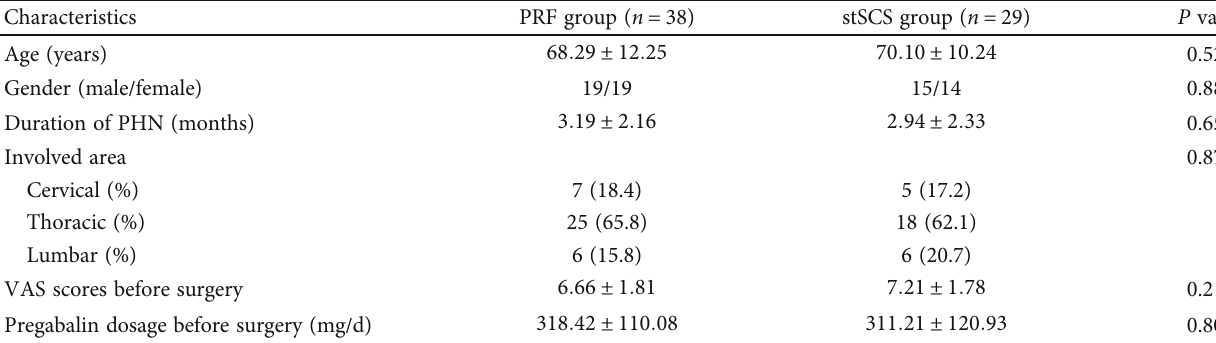
Table 1: Preoperative characteristics of the patients.